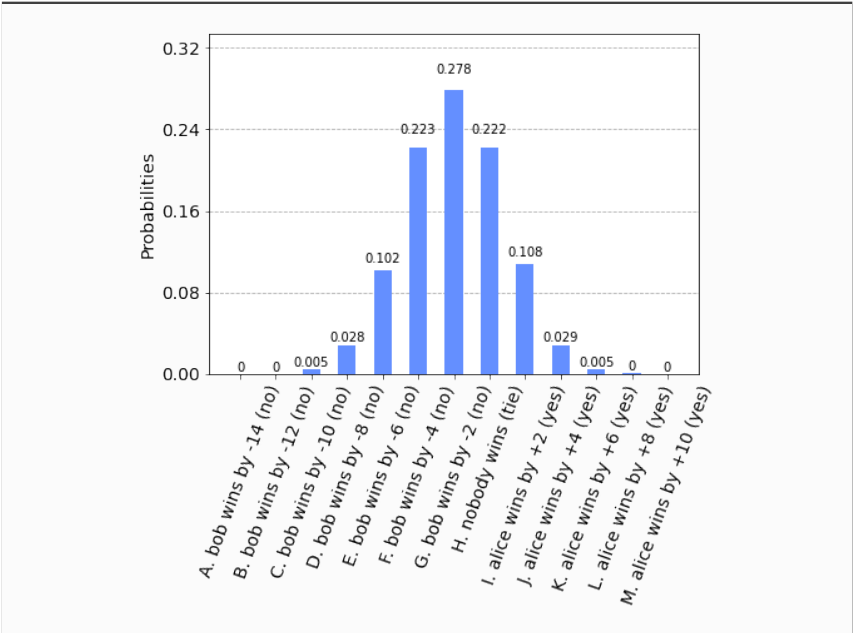
Figure 16. The possible outcomes and their probabilities when r A = 1.0 and r B =